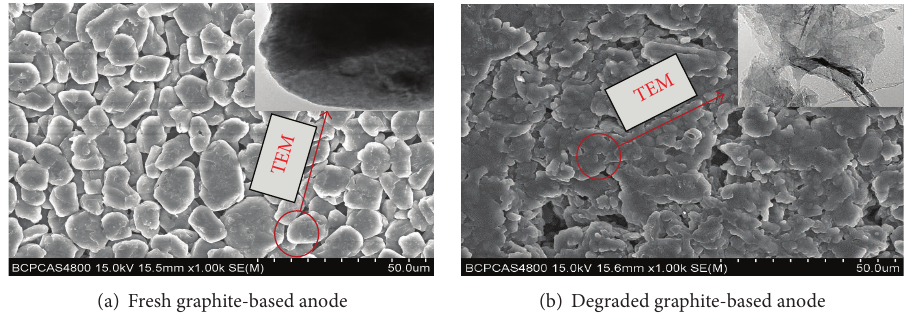
Figure 4: SEM images of (a) fresh graphite-based anode before cycling tests and (b) degraded graphite-based anode after 500 cycles.